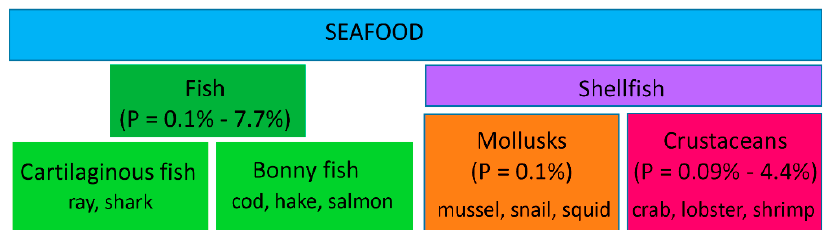
Figure 1. Seafood species classification and their reported allergy prevalence. The classification was performed according to the NCBI taxonomy as described [5]. Examples of each of the species are displayed in the corresponding boxes. The range of the prevalence (P) of each offending food has been taken from References [3,5].